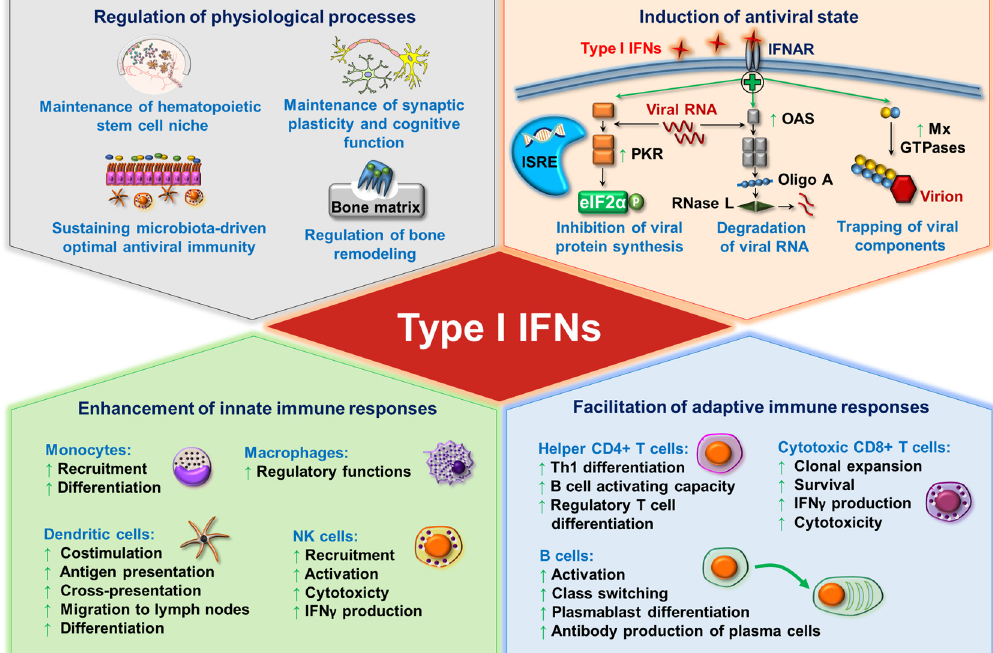
Figure 1. The pleiotropic effects of type I interferons (IFNs). Continuous baseline production of type I IFNs by various tissues and cells fine-tunes a wide variety of physiological processes including hematopoietic stem cell functions, synaptic plasticity, bone remodeling and immune homeostasis. In addition, the microbiota-induced basal IFN-signature prepares stromal and immune cells for upcoming infections ( upper left panel ). Upon viral infection, type I IFN signaling induces antiviral state in all nucleated cells via the upregulation of IFN-stimulated genes that inhibit the replication and spreading of viruses ( upper right panel ). Type I IFNs also control the cells of innate ( lower left panel ) as well as adaptive ( lower right panel ) immune system by shaping the activation, differentiation, effector functions and trafficking of these cells.